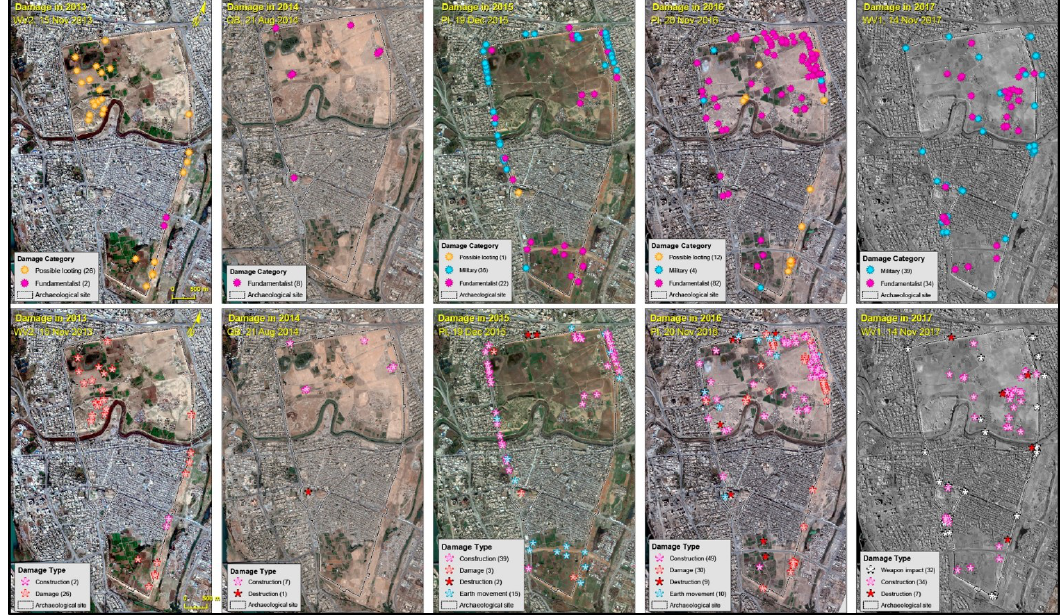
Figure 10. Distribution of damage by category (top-half) and type (bottom-half) per year (2013–2018).